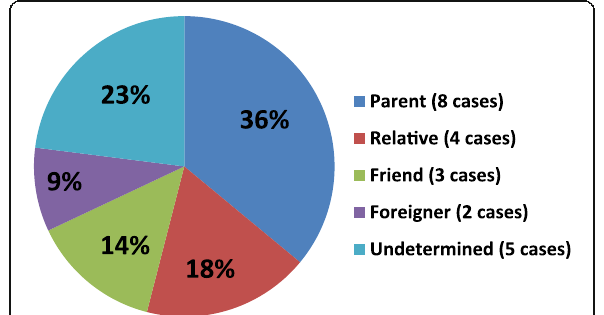
Table 3 Distribution of the manner in relation to cause of